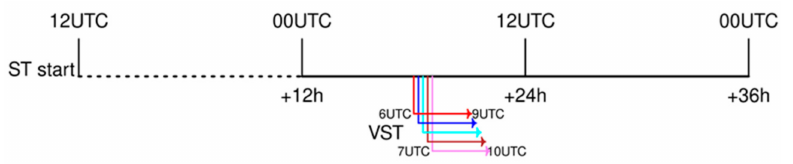
Figure 4. Temporal scheme representing the overlapping between the ST and the VST